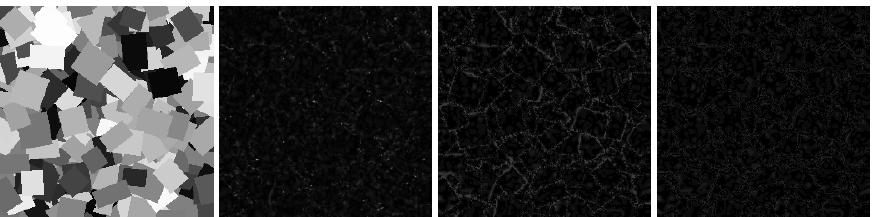
Figure 5. Visual quality comparison of denoising results for piecewise constant image. Images of the absolute errors are displayed in the dynamic range [0,20] (from left to right): Original image, noise image, analysis KSVD [14], synthesis KSVD [9], our proposed method.